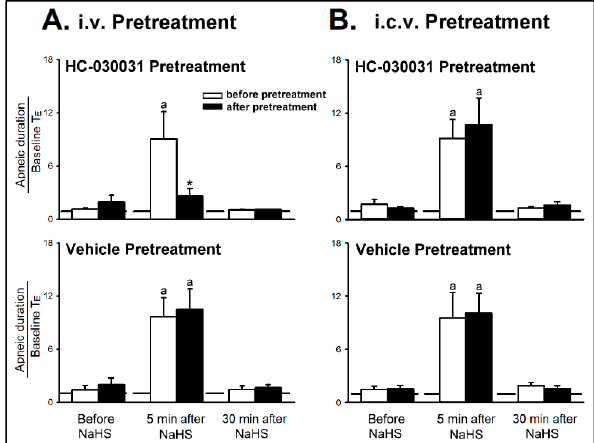
Figure 5. The role of TRPA1 receptors in sodium hydrosulfide (NaHS)-induced enhancement of apneic response in four groups of anesthetized, spontaneously breathing rats. ( A ) Effect of pretreatment of intravenous (i.v.) and ( B ) intracerebroventricular (i.c.v.) HC-030031 on the enhancing effects of NaHS inhalation on the apneic responses to right-atrial injections of adenosine (1.2 mg/kg). Data are means ± SE of six rats. a , significantly different from before NaHS ( p < 0.05); *, significant difference when corresponding data between before and after pretreatment were compared ( p < 0.05).